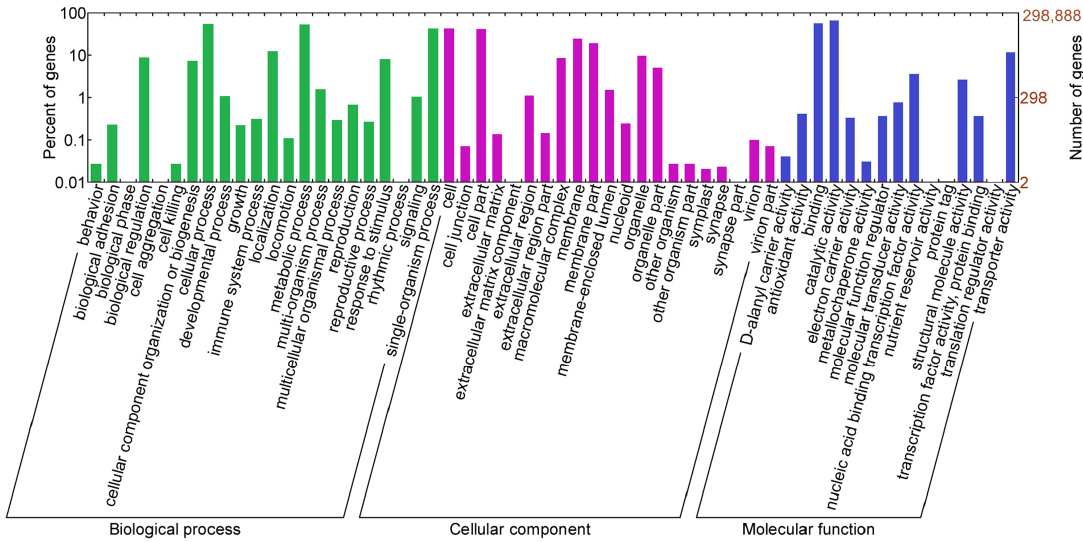
Figure 5. GO functional classification of functional genes in suansun microorganisms.